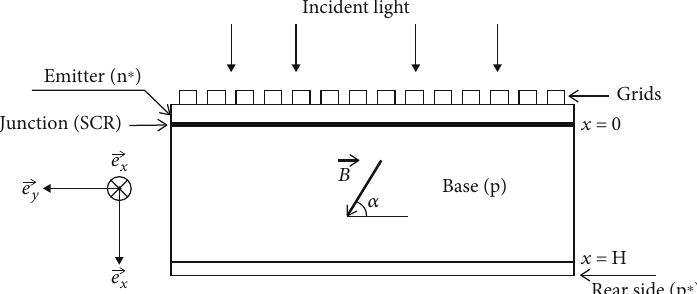
Figure 1: PV cell subjected to a constant multispectral illumination and under the e ff ect of the inclination α of the applied MF vector.